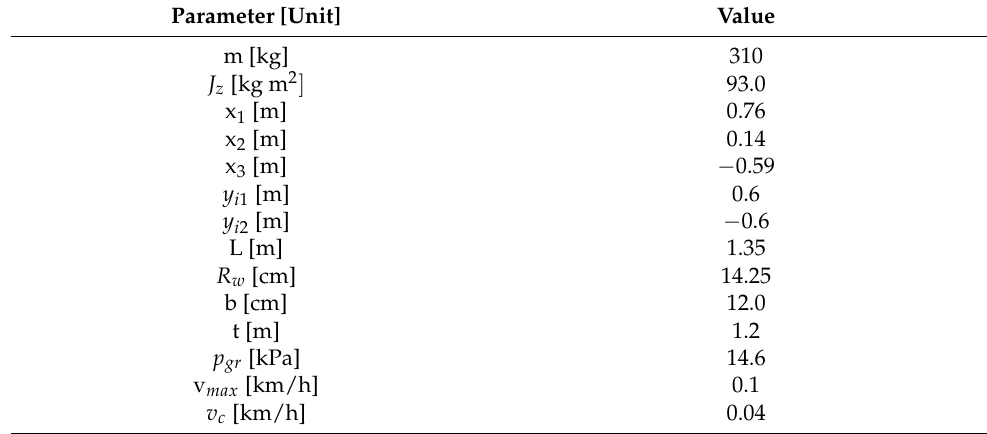
Table 1. Properties of the 3-axle simulated rover based on the ESA ExoMars mission [25]. J z is the rover’s moment of inertia, x ij is the distance between the centre of mass of the rover and the i-th axle, y ij is the distance from the longitudinal axis to the ij-th wheel, t is the distance between the kingpin axes of the wheels and v max and v c are the vehicle’s maximum and nominal